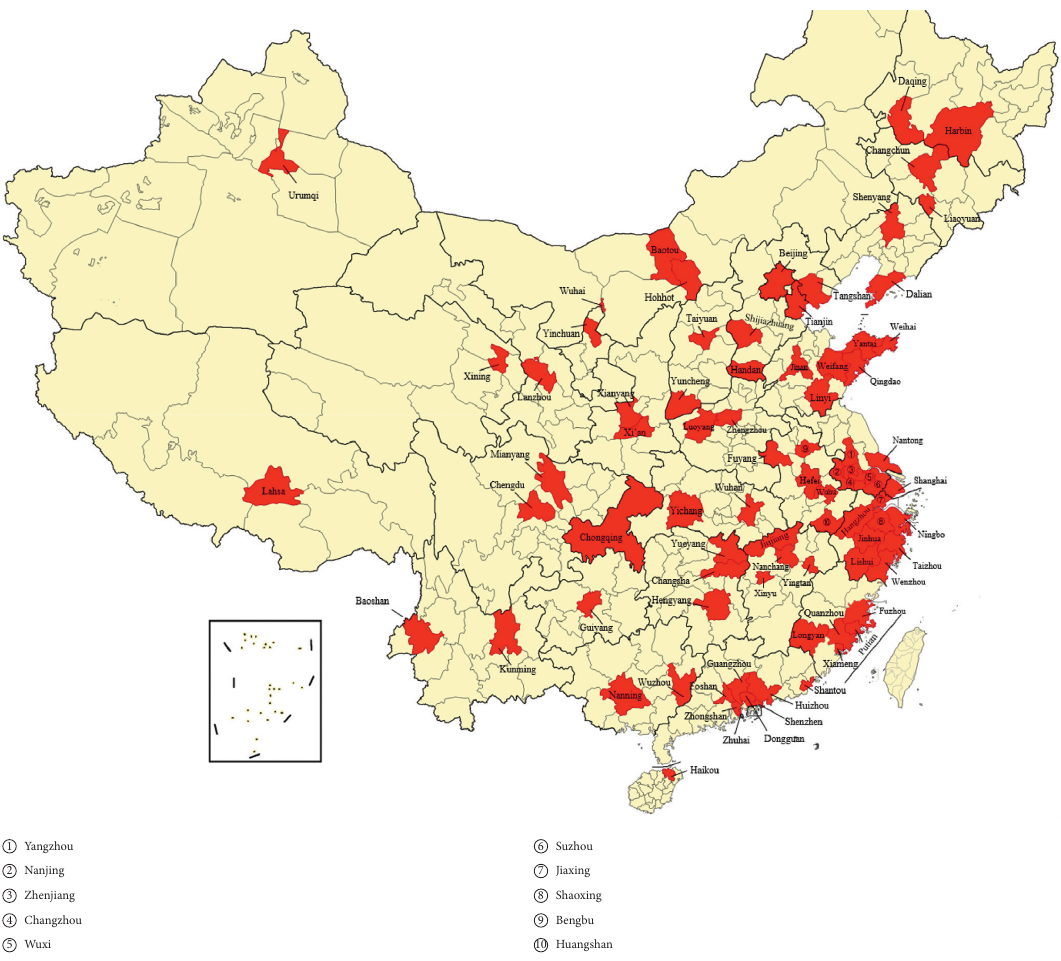
Figure 2: 83 smart cities in